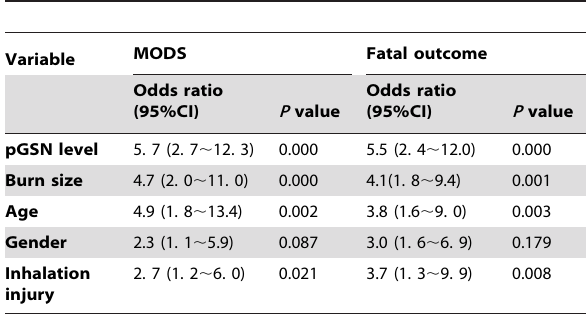
Table 4. Multiple logistic regression models of independent risk factors for MODS and fatal outcome of burn